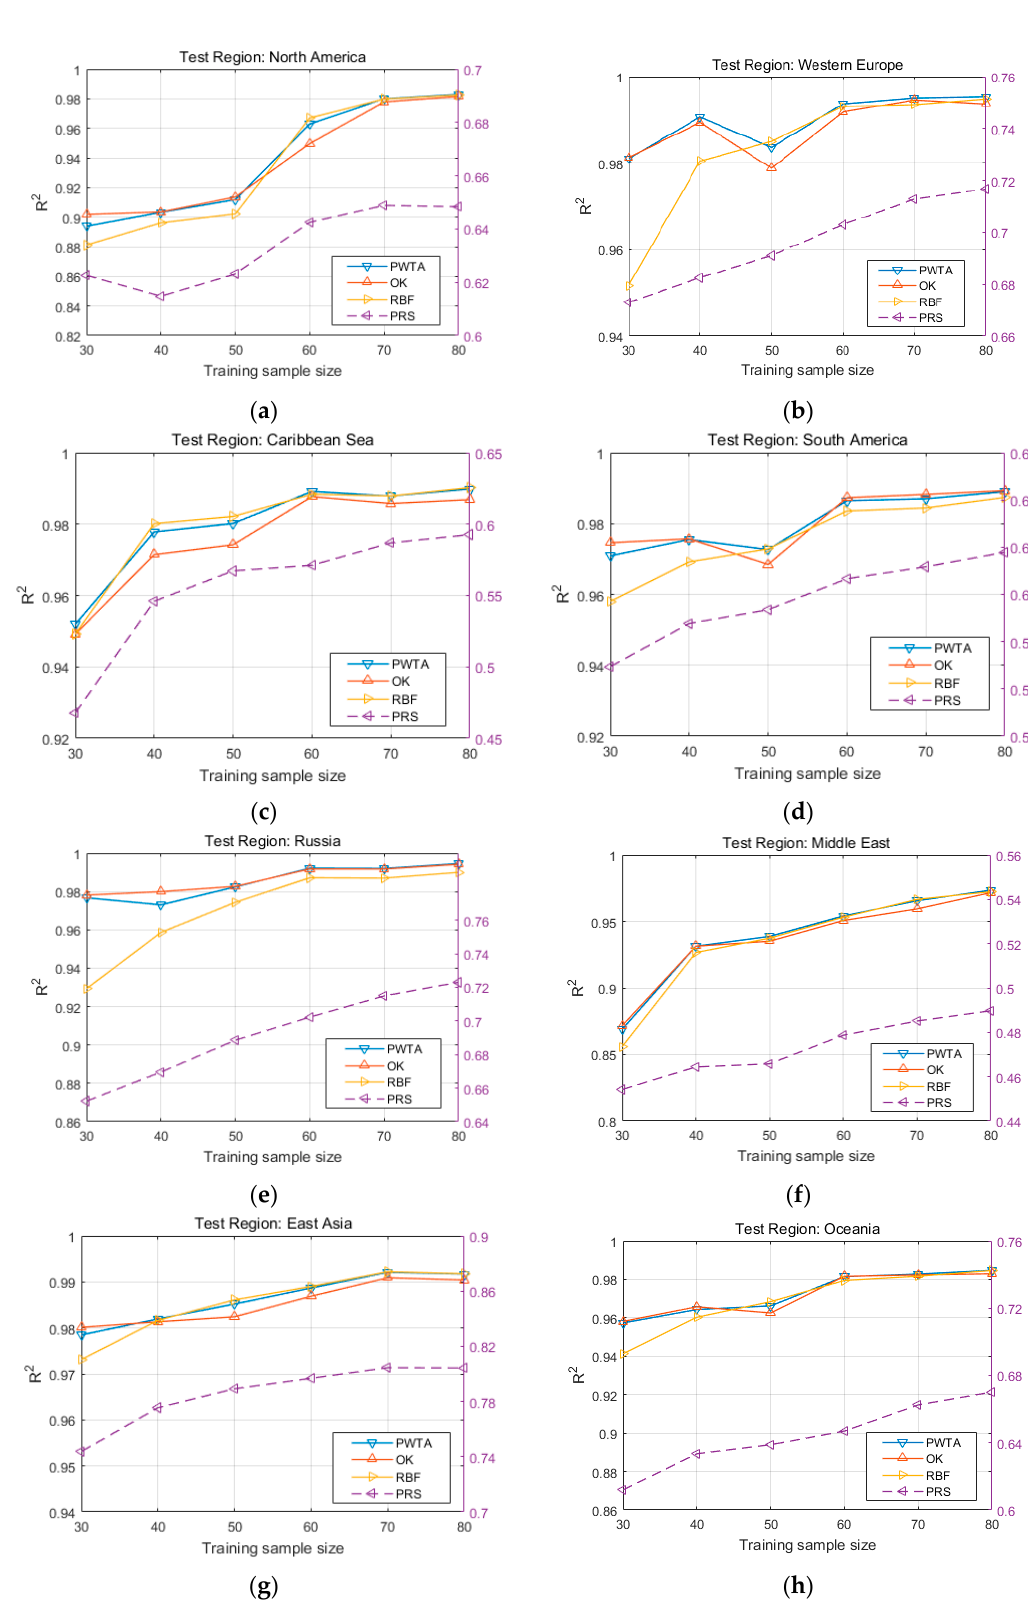
Figure 4. R 2 varying with training sample size of di ff erent surrogates in ( a ) North America, ( b ) Western Europe, ( c ) Caribbean Sea, ( d ) South America, ( e ) Russia, ( f ) Middle East, ( g ) East Asia and ( h ) Oceania. For clarity, R 2 of the PRS surrogate are indicated by the dashed purple line with the purple y -axis on the right, and the others are presented by the solid line with the black y -axis on the left.